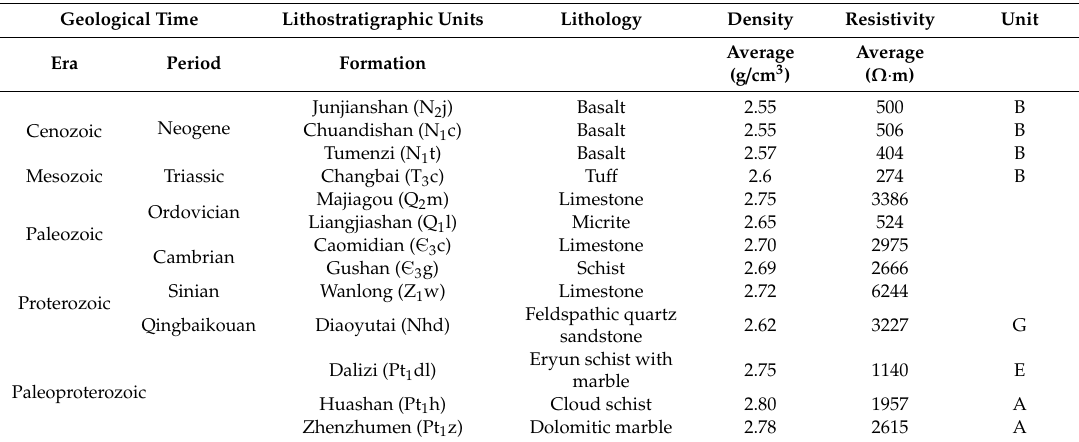
Table 4. Statistical table of stratigraphic